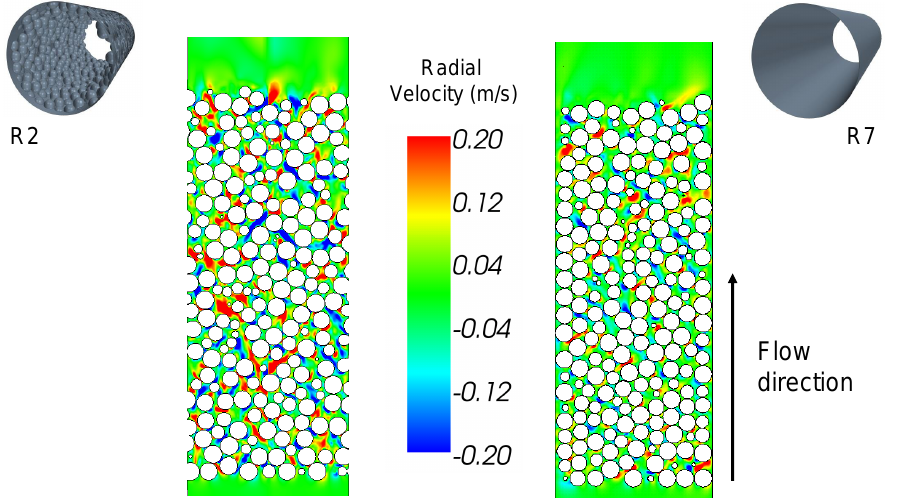
Figure 9. Comparison of the local radial velocity between configuration R2 with wall structure and R7 for a D / d p -ratio of